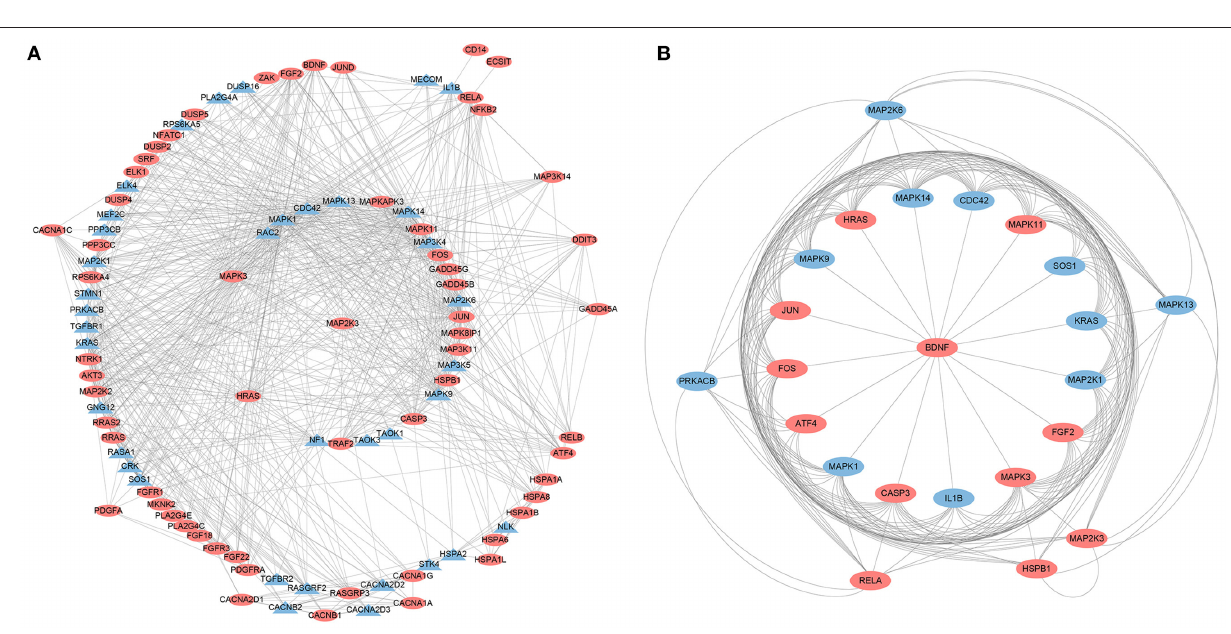
Frontiers in Nutrition |